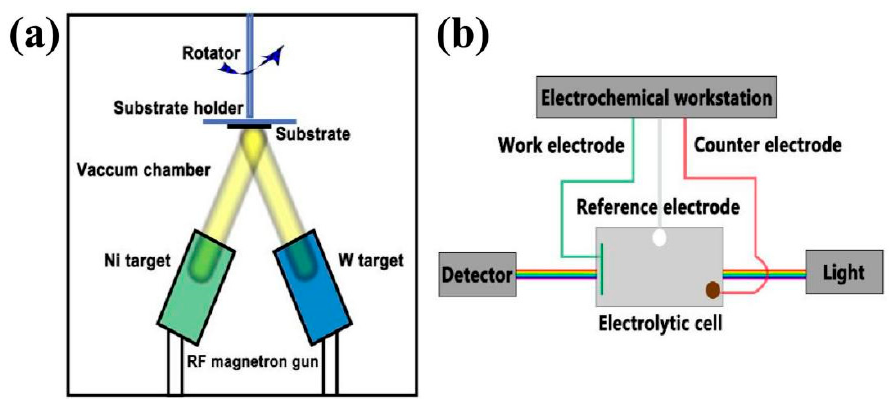
Figure 1. Schematic diagram of the equipment used for preparation and measurement. ( a ) RF magnetron co-sputtering equipment. ( b ) In situ spectral–electrochemical testing